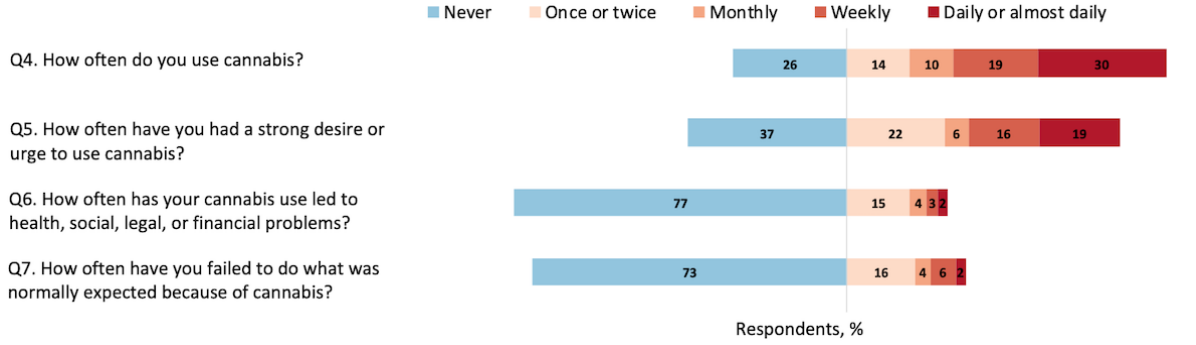
JMIR Form Res 2021 | vol. 5 | iss. 3 | e25583 | p. 5https://formative.jmir.org/2021/3/e25583 (page number not for citation